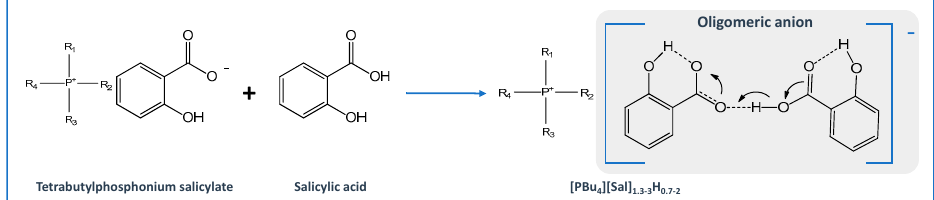
Figure 13. Schematic representation of the formation of oligomeric ions based on salicylate/salicylic acid proposed in [153].